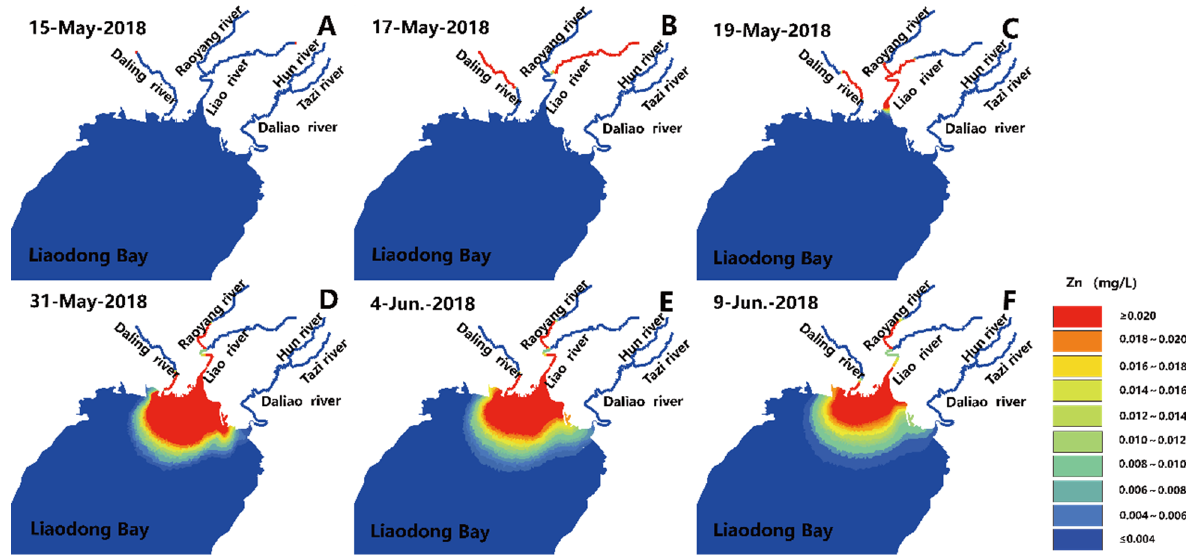
Figure 9. Pollutant transmission and propagation in the sudden water pollution accident in Liao River.